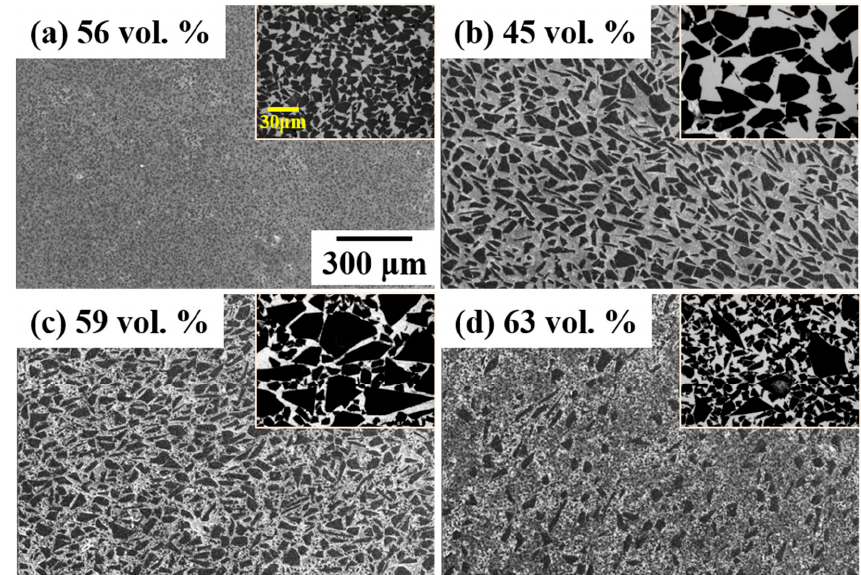
Figure 1. Scanning electron microscope (SEM) images of the ( a ) MS60; ( b ) MS24; ( c ) BS13; and ( d ) BS31 composites with a calculated SiC volume fraction (at the same magnification).